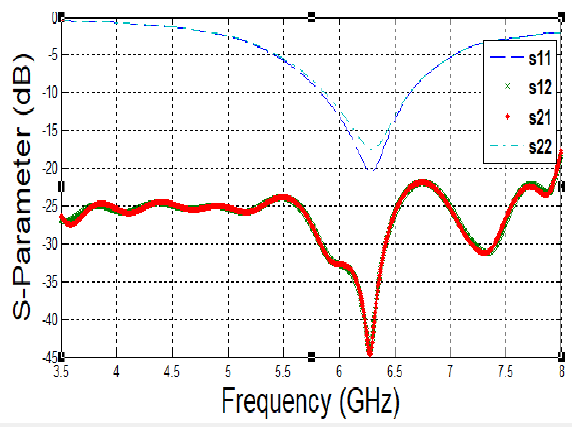
FIGURE 4: S-Parameter for single